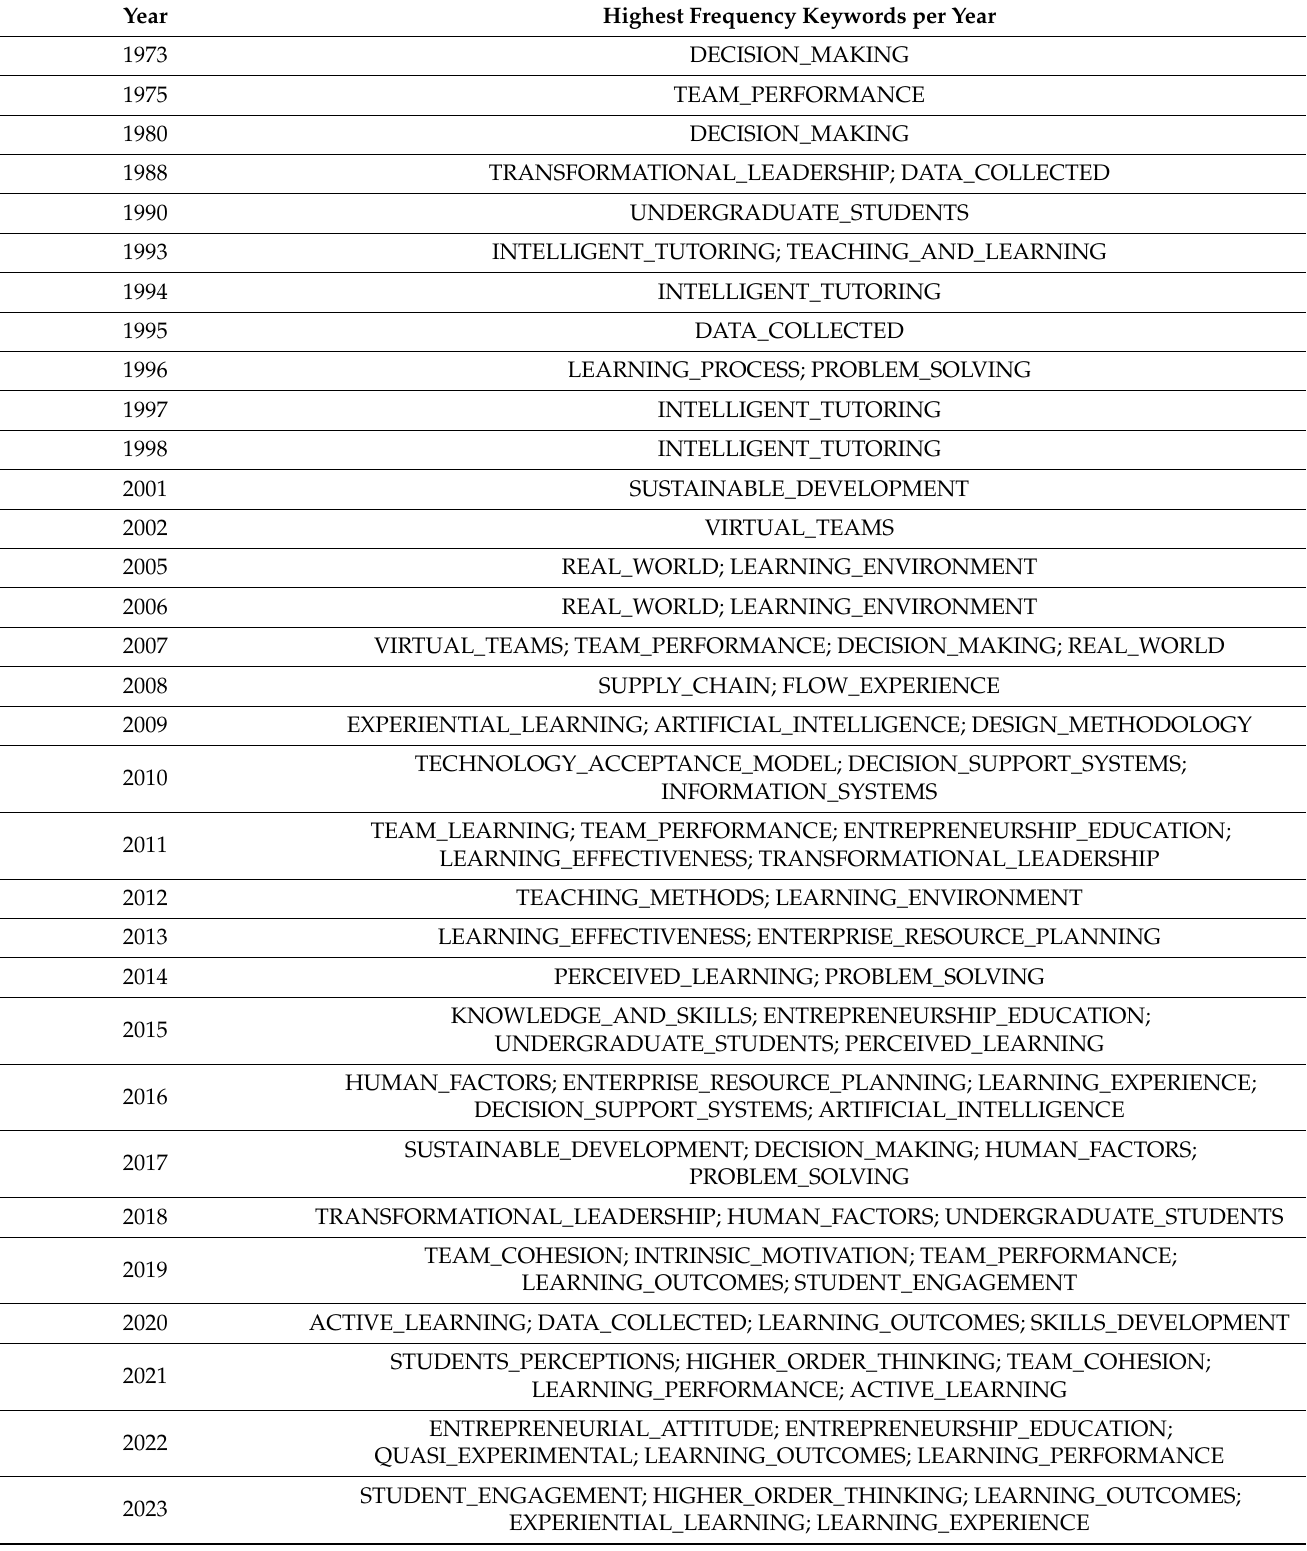
Table 7. Highest frequency keywords per